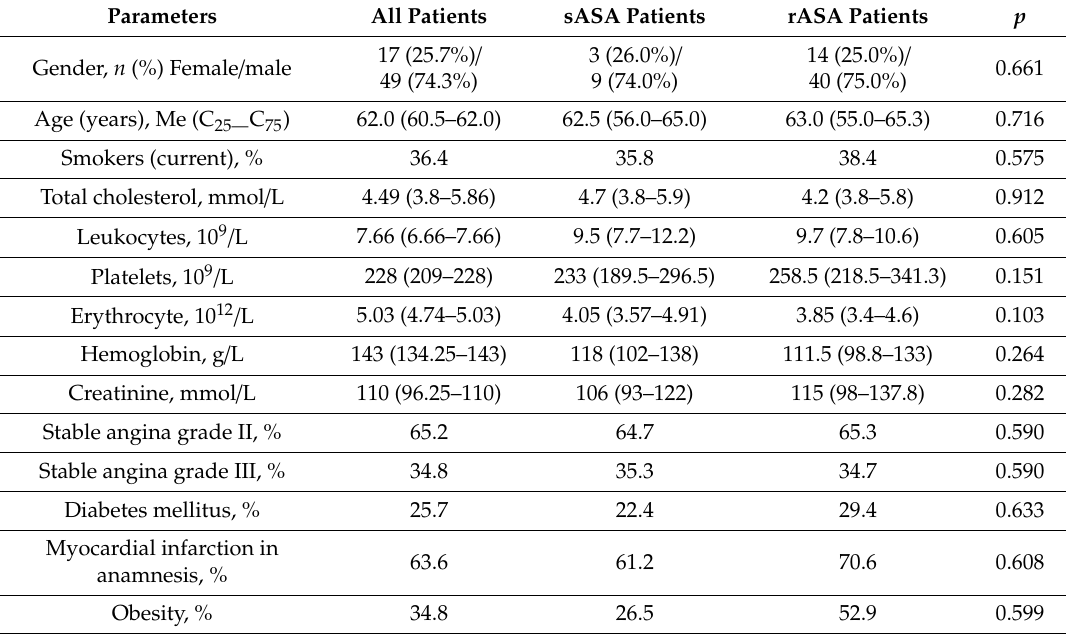
Table 2. Baseline characteristics of participants completing the